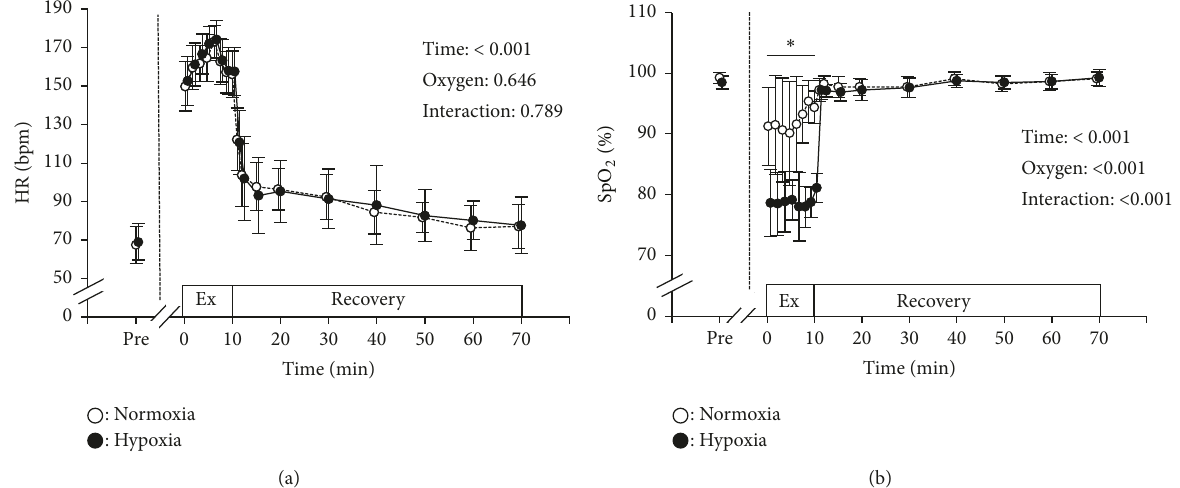
Figure 3: Changes in HR (panel (a)) and SpO 2 (panel (b)) at baseline (pre) and during exercise and recovery. Circles indicate the same as in Figure 2. ∗ indicates a significant difference between normoxia and hypoxia within the same time period.